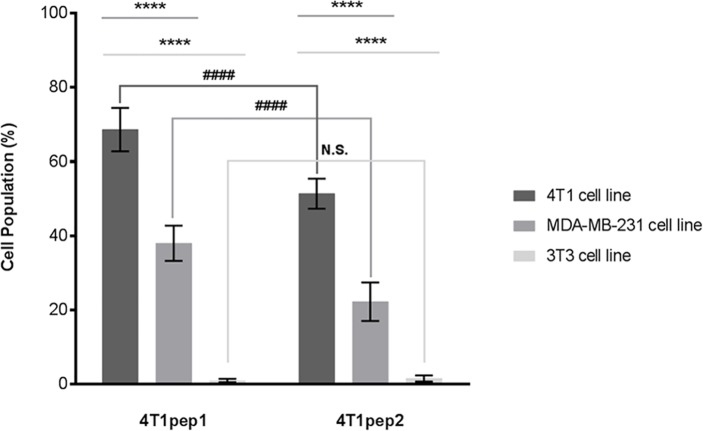
Flow cytometry results expressing the percentage of binding of the peptides 4T1pep1 and 4T1pep2 to 4T1, 3T3 and MDA-MB-231 cell lines.All data are expressed as the mean ± SD of three independent experiments. Two-way ANOVA indicates statistically significant differences within the group assessed by Bonferroni post-test and denoted as follows: ****p < 0.0001 indicates comparison between cell lines for the same peptide and ####p < 0.0001 comparison of the two peptides for the same cell line. N.S. indicates no significant difference (p > 0.05).